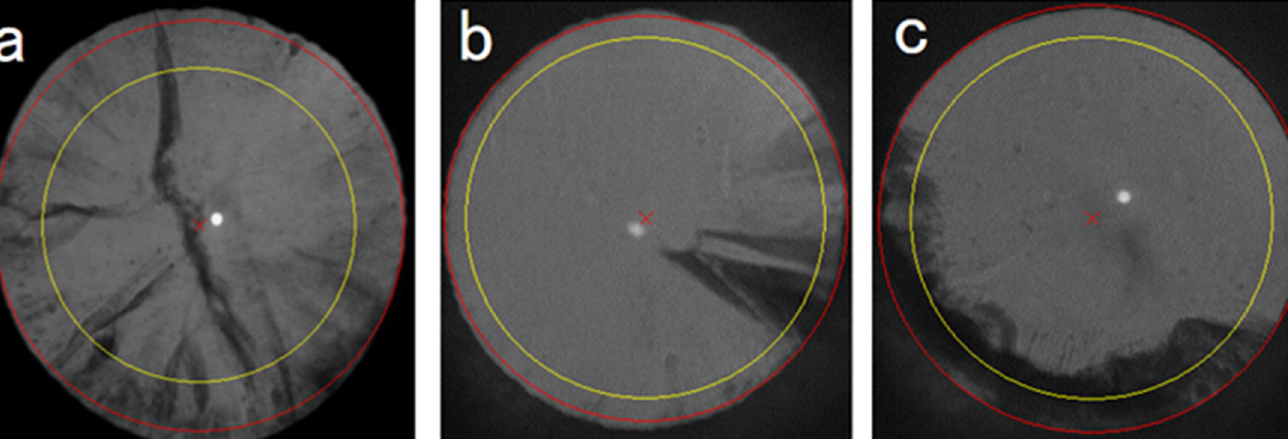
PLOS ONE | https://doi.org/10.1371/journal.pone.0215338 April 25,